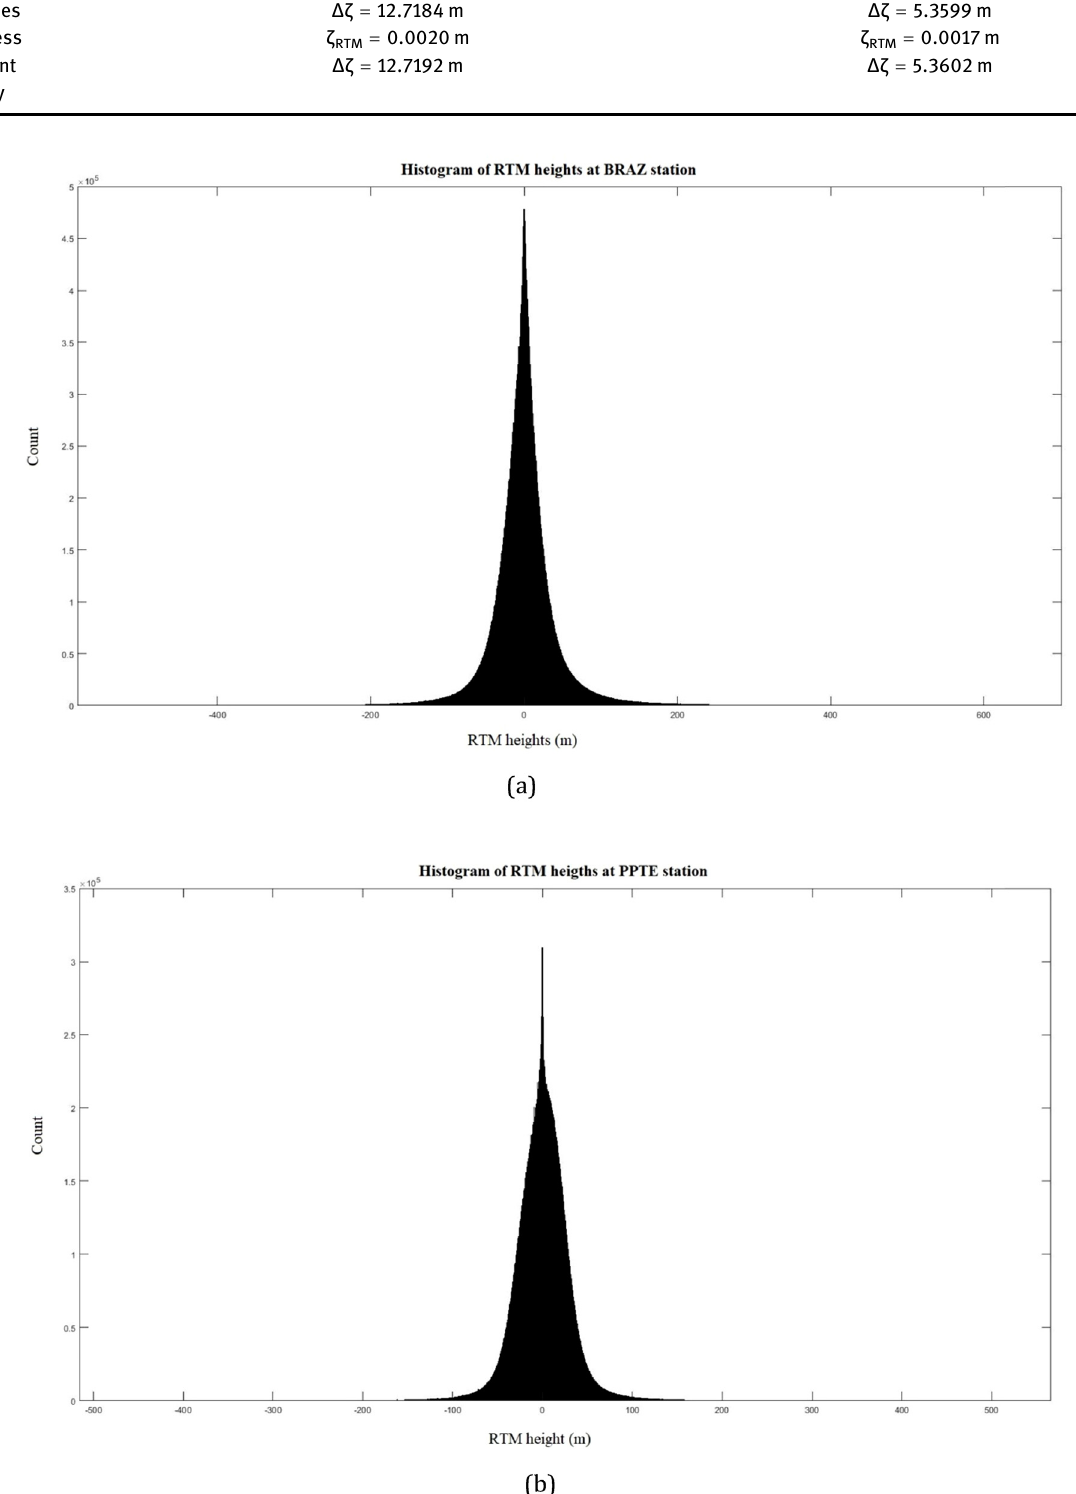
Figure 12: Histograms of RTM heights at ( a ) BRAZ and ( b ) PPTE